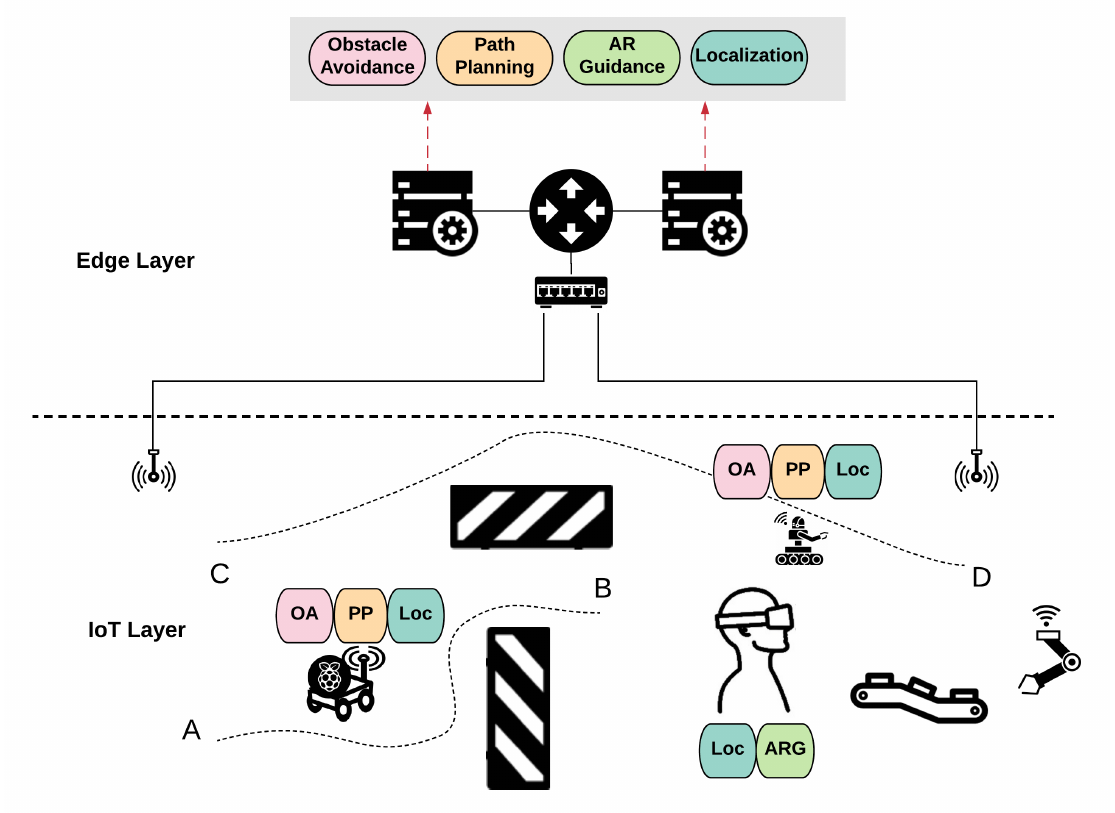
Figure 2. Human–Robot